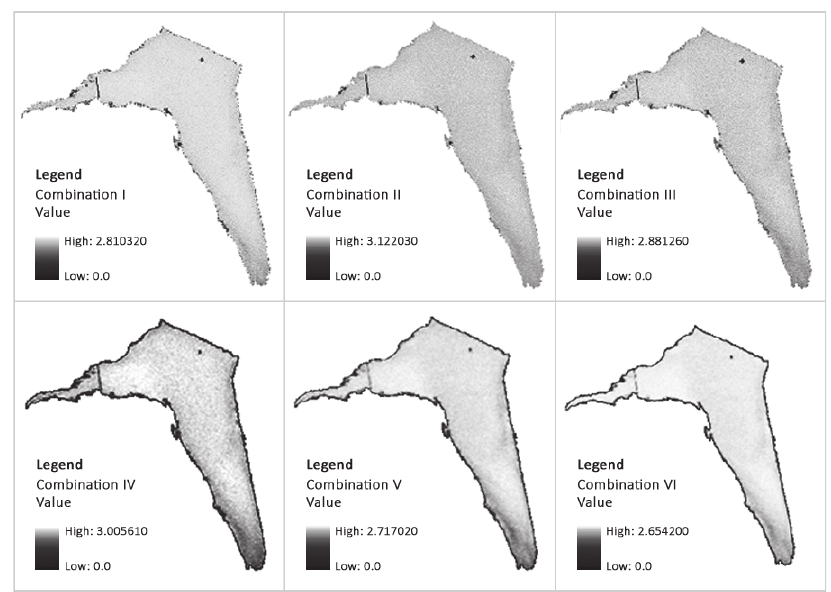
Figure 3 - Spatial representation of values inferred by different confi gurations of